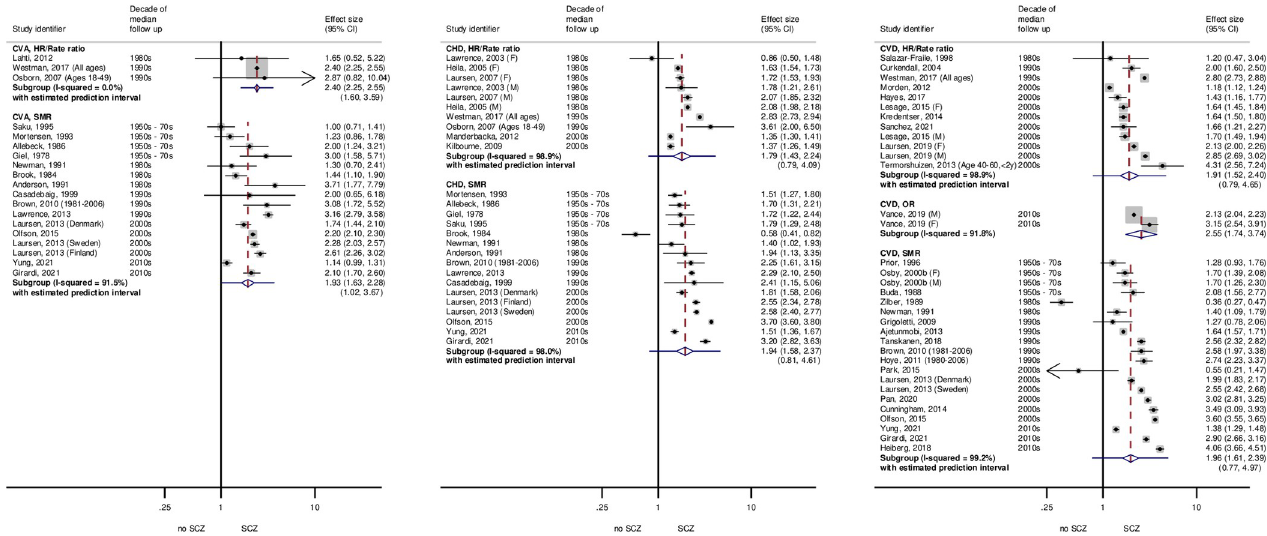
Fig 2. Forest plots showing relative risk of CVD mortality in those with versus without schizophrenia, studies included in meta-analysis. Weights are from random effects model. Dashed lines show pooled estimated risks within subgroups. Studies were allocated to decades according to the median year of follow-up. CHD, coronary heart disease; CVA, cerebrovascular accident; CVD, all circulatory disease; F, female; HR, hazard ratio; M, male; OR, odds ratio; SCZ, schizophrenia; SMR, standardised mortality ratio.